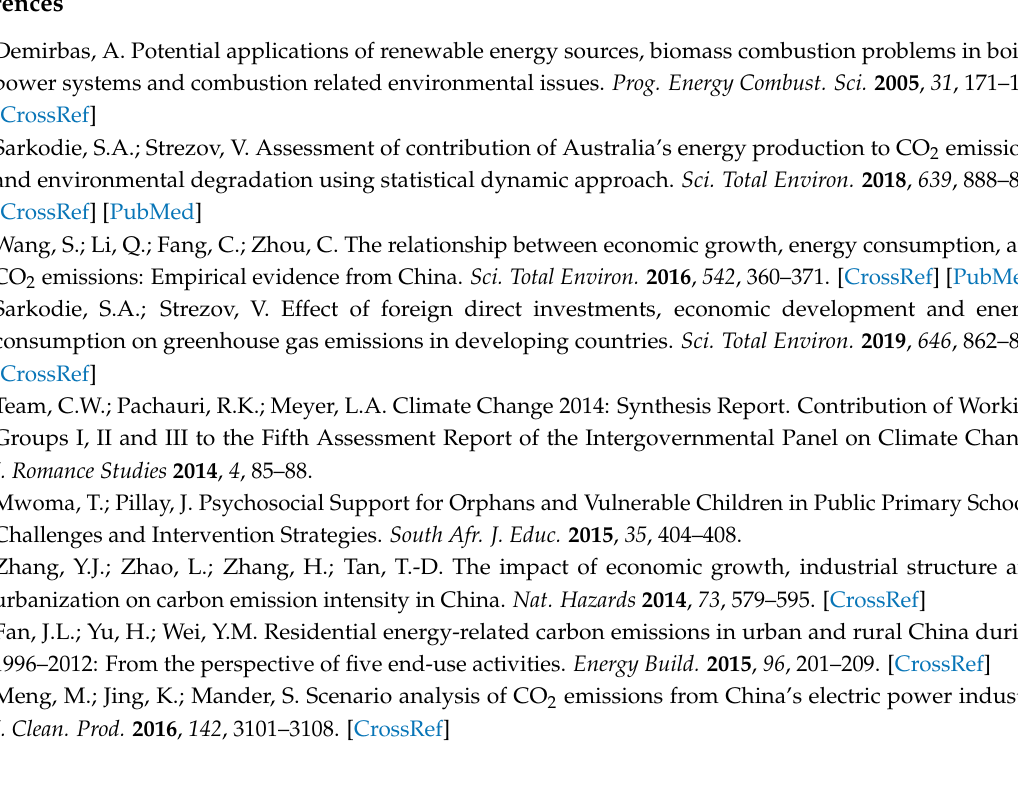
Table S1: The major parameters used in sub-sector for TOS in the LEAP-Hebei model; Table S2: The major parameters used in sub-sector for LCD in the LEAP-Hebei model; Table S3: The related power production structure of REF, ISO, TOS and LCD used in the LEAP-Hebei